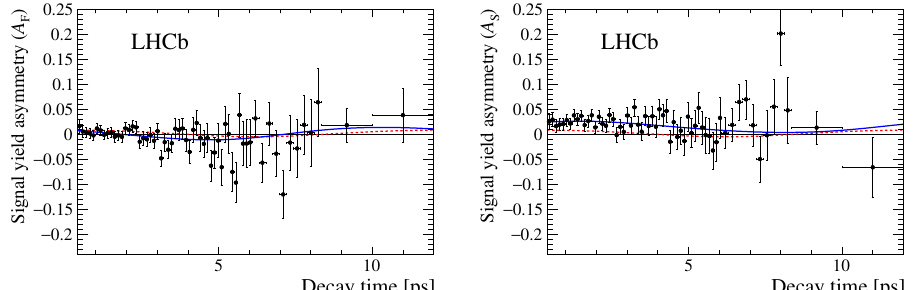
Figure 4 . Decay-time-dependent signal-yield asymmetries for (left) the favoured and (right) the suppressed decays. The signal-yield asymmetries are de(cid:12)ned in eq. (6.4) and eq. (6.5). The blue solid curve is the projection of the signal PDF, the red dotted curve indicates the projection of the (cid:12)t when CP conservation is